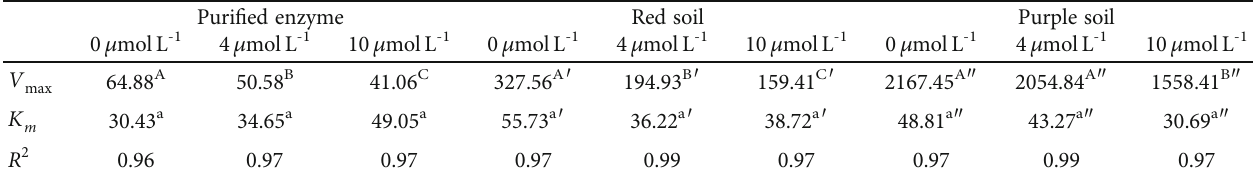
and K m ) of LAP by di ff erent concentrations of Cd. max